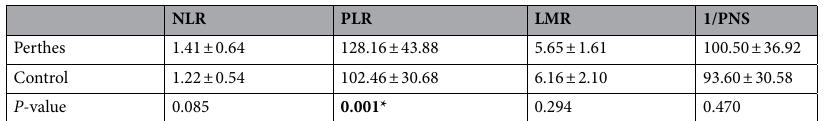
Table 2. Comparison of inflammatory indexes between Perthes group and control group. Significant values are in bold. *Statistically